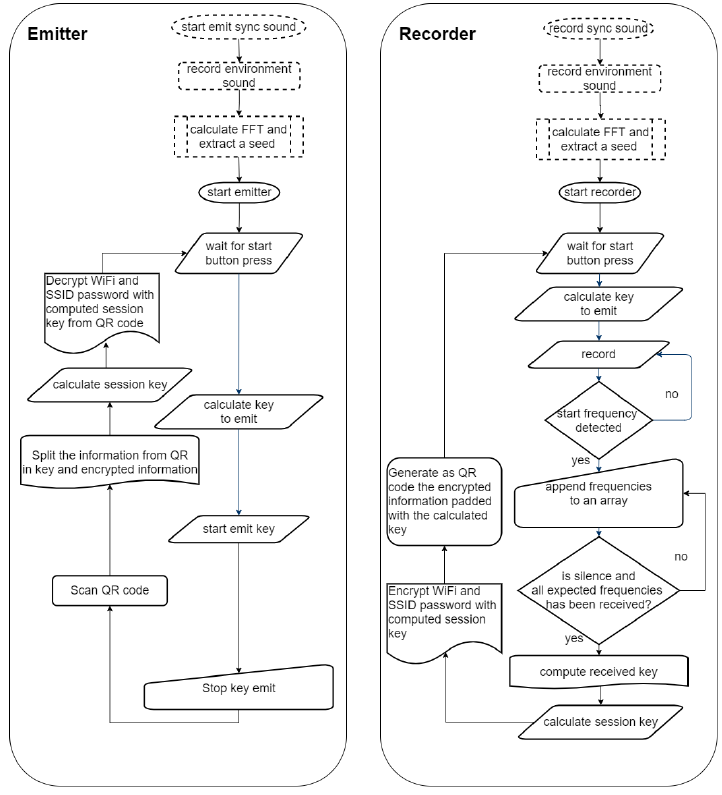
Figure 8. The flowchart of the proposed